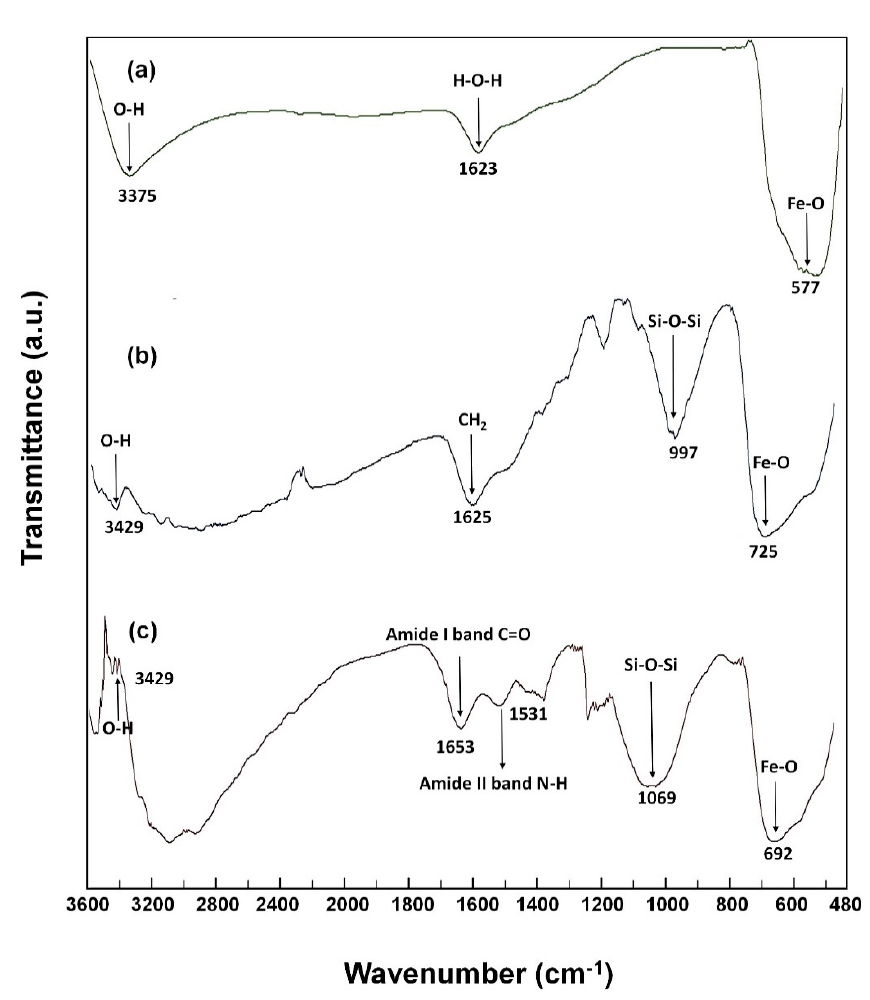
Figure 3. FTIR spectra of bare ( a ) and APTES-coated ( b ) MNPs, and N450D-mCLEAs ( c ).